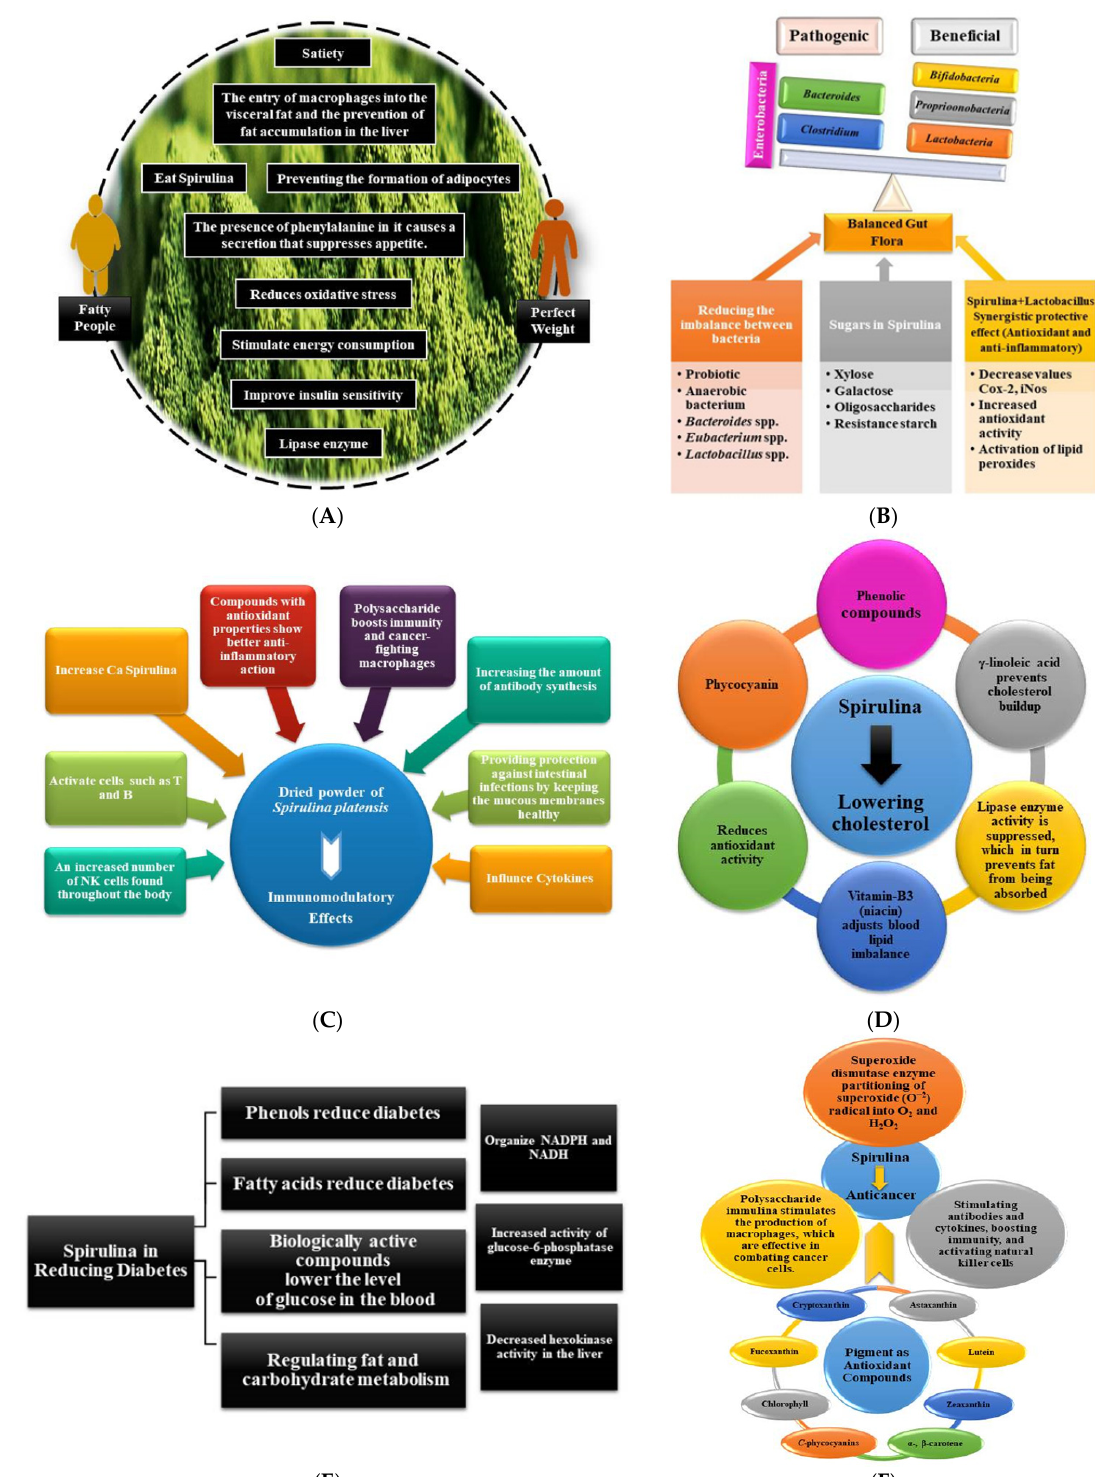
Figure 3. A pictorial representation of the numerous beneficial health effects that have been derived from consuming spirulina algae and their associated bioactive components. ( A ) Role of spirulina algae play in the process of weight loss; ( B ) How consuming spirulina algae might alter the pattern of the intestinal balance; ( C ) Role played by spirulina algae in the regulation of immunity; ( D ) Function that spirulina algae play in reducing cholesterol levels; ( E ) Role that spirulina algae play in lowering the risk of developing diabetes; and ( F ) Anticancer properties of the spirulina